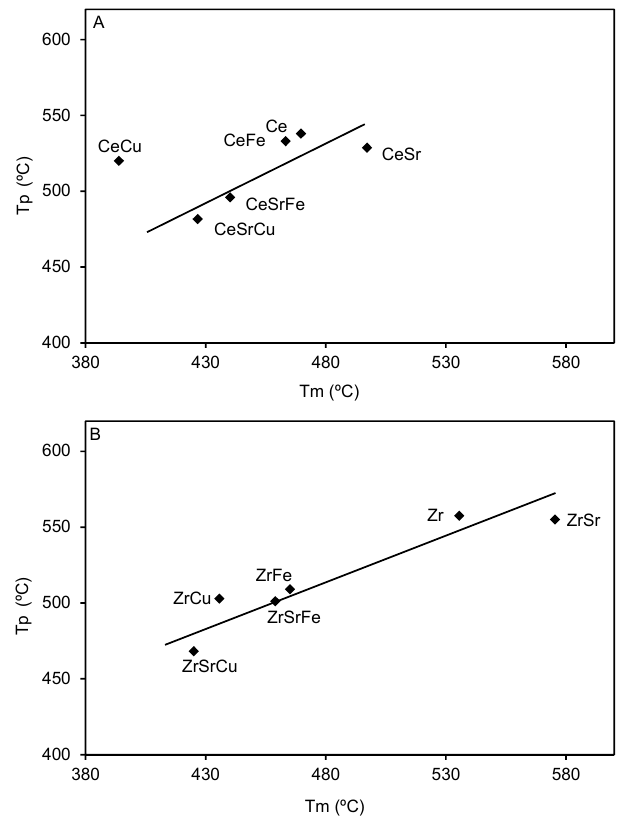
Figure 6. Correlation between Tp and Tm for ( A ) Ce ‐ and ( B ) Zr ‐ based catalysts.